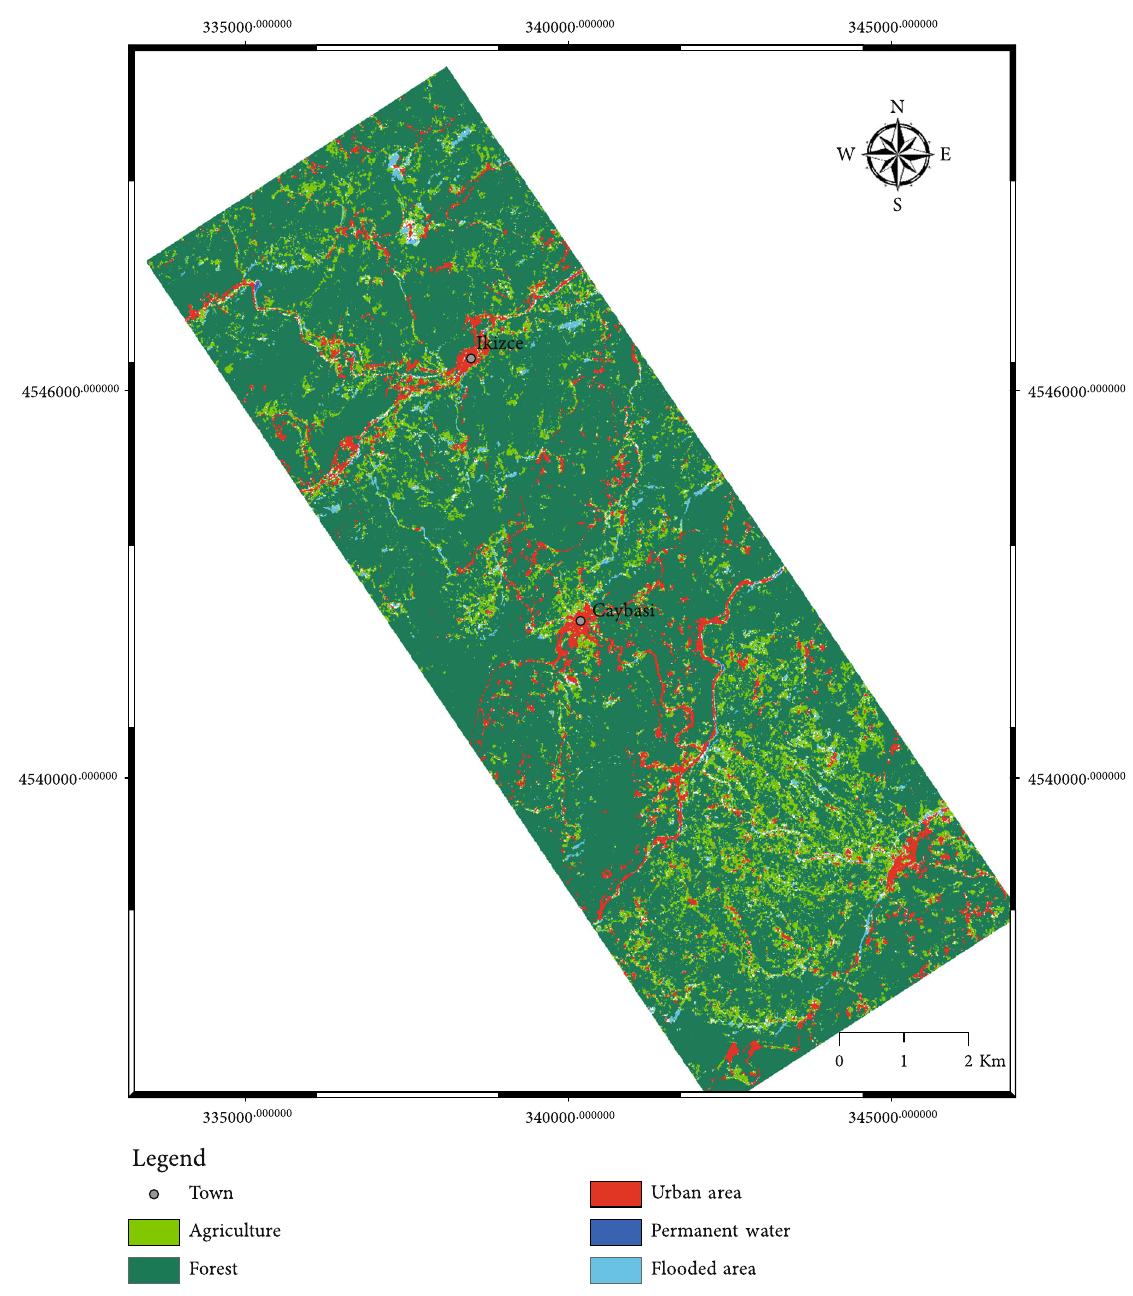
Figure 13: Result of the fl ood analysis produced for Ik ı zce-Caybas ı